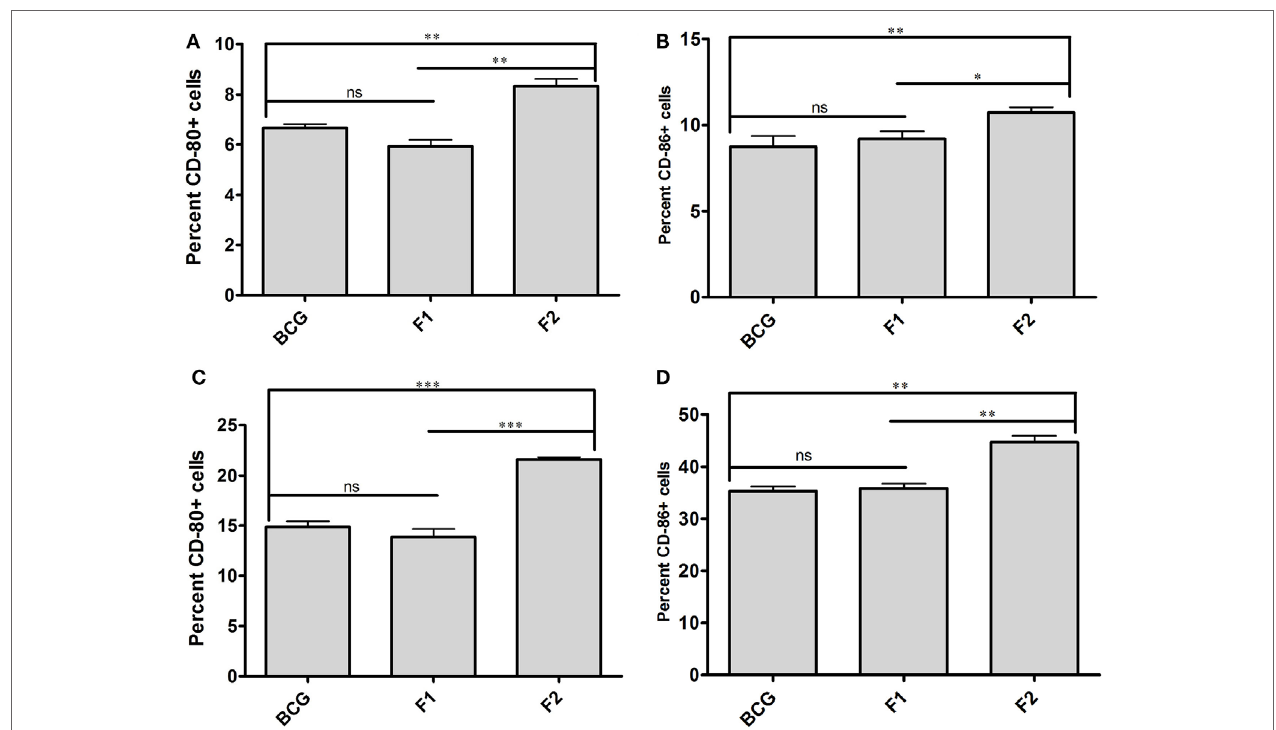
FigUre 7 | Aggregated Ag85B upregulates expression of co-stimulatory molecules on APCs. Expression level of signature co-stimulalotry molecules CD80 (B7.1) and CD86 (B7.2) on isolated CD11c + APCs belonging to various experimental groups, namely; Bacillus Calmette–Guerin (BCG), Ag85B-IFA (F1), and aggregated Ag85B (F2) were determined through flow cytometry at various time points. The data correspond to 6 (a,B) , and 10 (c,D) weeks post challenge time points, respectively. The experiment was repeated thrice and data represent means ( ± SEM) from three independent experiments. Various immunized groups were compared to determine statistical significance of the data using One-way ANOVA following by Bonferroni’s multiple comparison test analysis with p < 0.05(*) as minimum level of